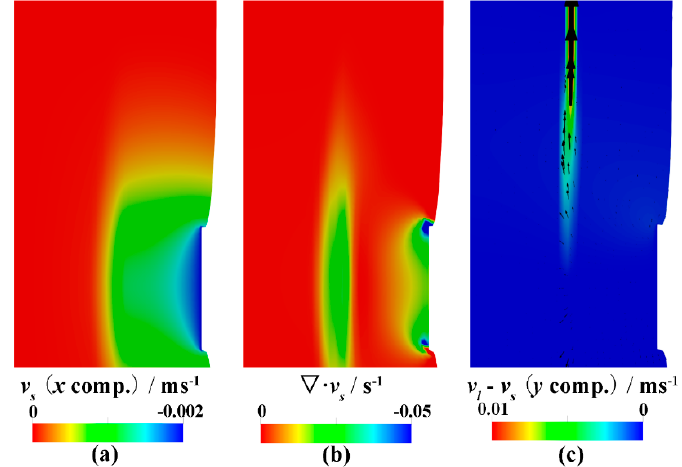
Figure 11. The horizontal component of the solid velocity ( a ), divergence of the solid velocity ( b ), and relative velocity v l – v s ( c ) of the ingot at punch height.